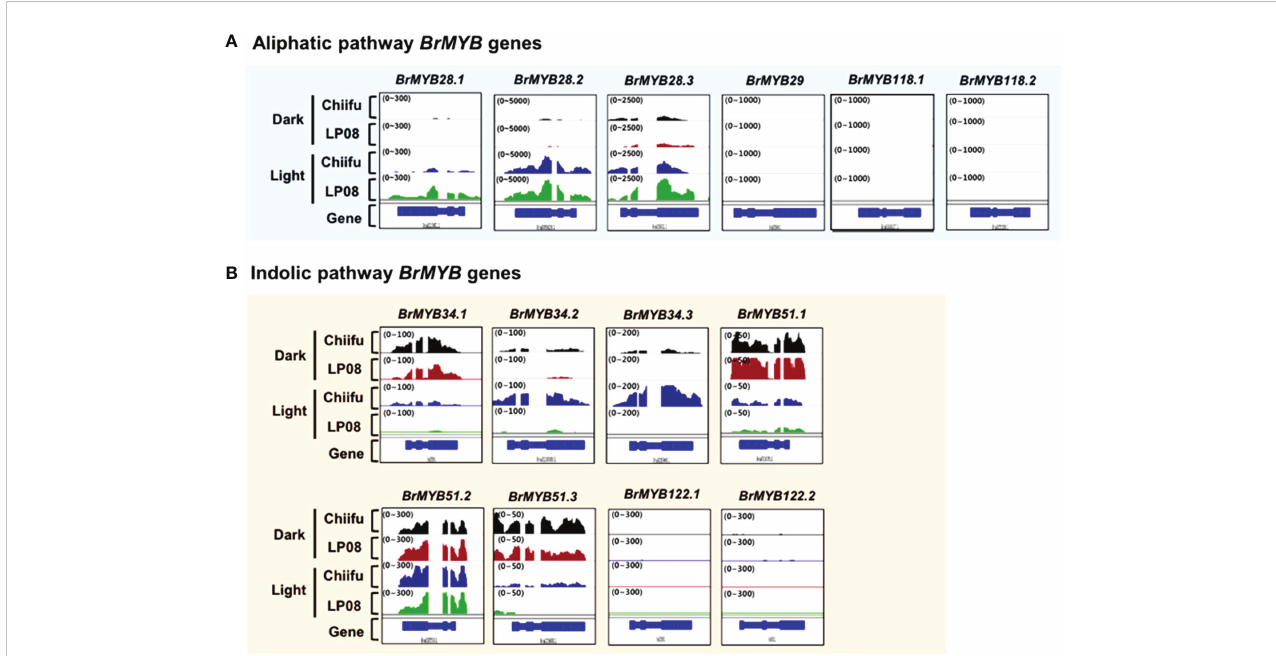
FIGURE 3 Expression pro fi les of BrMYB transcription factor (TF) genes between ‘ Chiifu ’ and ‘ LP08 ’ grown under light and dark conditions. (A) Integrative genome browser (IGV) illustration of the expression pro fi les of six BrMYB genes involved in the aliphatic GSL pathway. Normalized read counts for each gene are indicated by black, brown, blue, and green colors for ‘ Chiifu ’ grown in the dark, ‘ LP08 ’ grown in the dark, ‘ Chiifu ’ grown in the light, and ‘ LP08 ’ grown in the light, respectively. Read coverage normalized to the total number of mapped reads is indicated in parentheses at the top left corner of each track. (B) IGV illustration of the expression pro fi les of eight BrMYB genes involved in the indolic GSL pathway. Normalized read counts for each gene are indicated by black, brown, blue, and green colors for ‘ Chiifu ’ grown in the dark, ‘ LP08 ’ grown in the dark, ‘ Chiifu ’ grown in the light, and ‘ LP08 ’ grown in the light, respectively. Read coverage, normalized using the total number of mapped reads, is indicated in parentheses at the top left corner of each